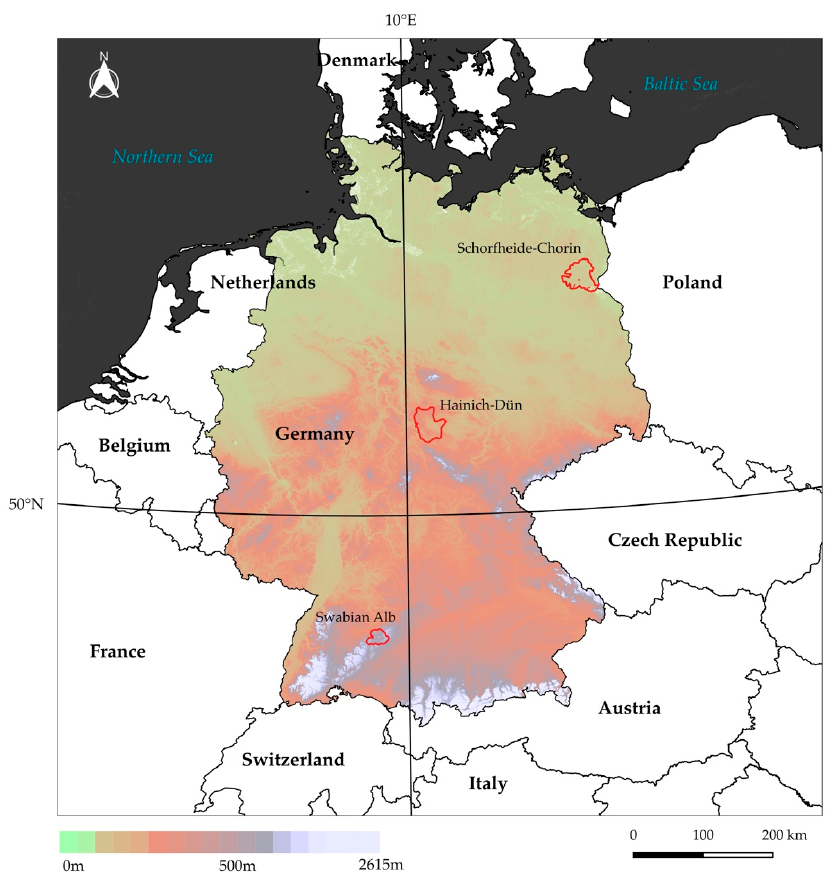
Figure 1. Locations of the three study sites across Germany. The background image shows the topographic gradient based on NASA Shuttle Radar Topography Mission (SRTM) data.